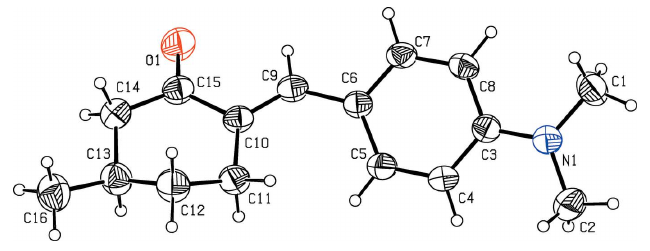
Figure 1 The molecular structure, with displacement ellipsoids drawn at the 30% probability level.